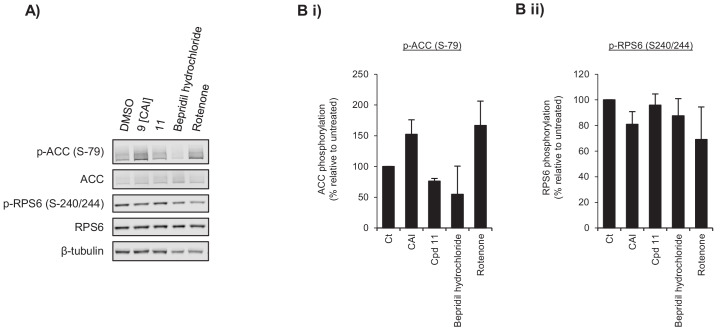
CAI inhibits signalling pathways responsive to changes in energy status.(A) Western blot analysis of A549 cells treated with 5 μM of CAI (9), 5 μM of 11 (inactive CAI derivative), 2.5 μM bepridil hydrochloride (non-specific calcium channel inhibitor) or 1 μM rotenone (complex I inhibitor) for 24 hr. (B) Quantification of (i) ACC (S-79) and (ii) RPS6 (S-240/244) phosphorylation from (E) displayed relative to the untreated sample. Error bars represent standard deviation (n = 3).